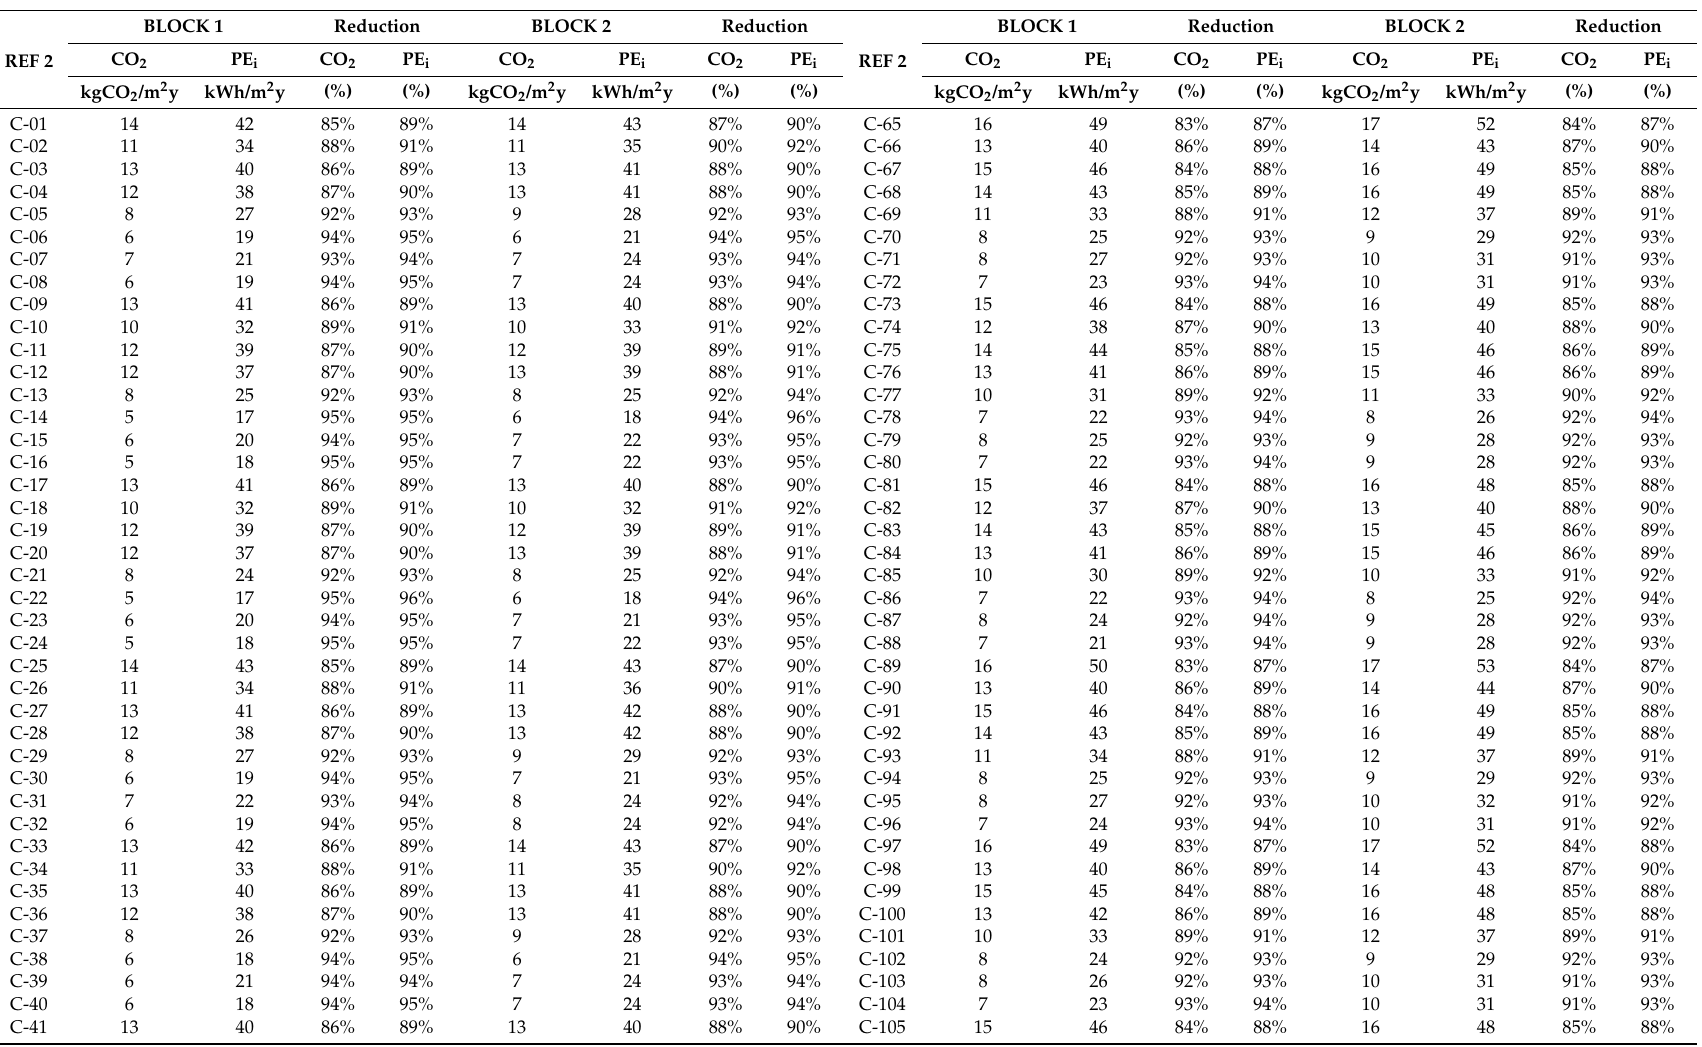
Table 9. Primary energy and CO 2 emissions values for Reference building